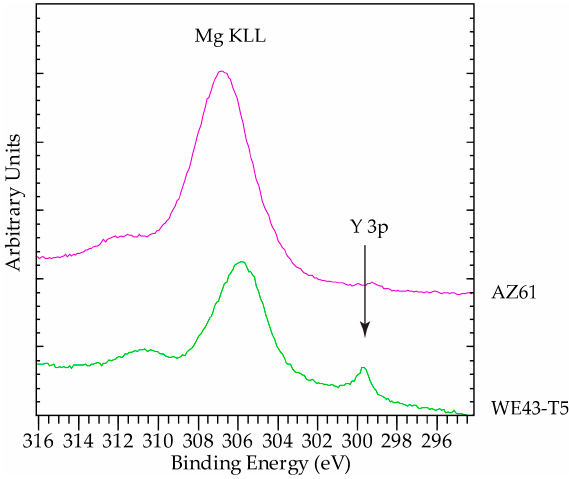
Materials 2023 , 16 , 1004 Figure 13. Mg KLL and Y 3p high resolution scans. Figure 13. Mg KLL and Y 3p high resolution scans. Figure 13. Mg KLL and Y 3p high resolution scans.